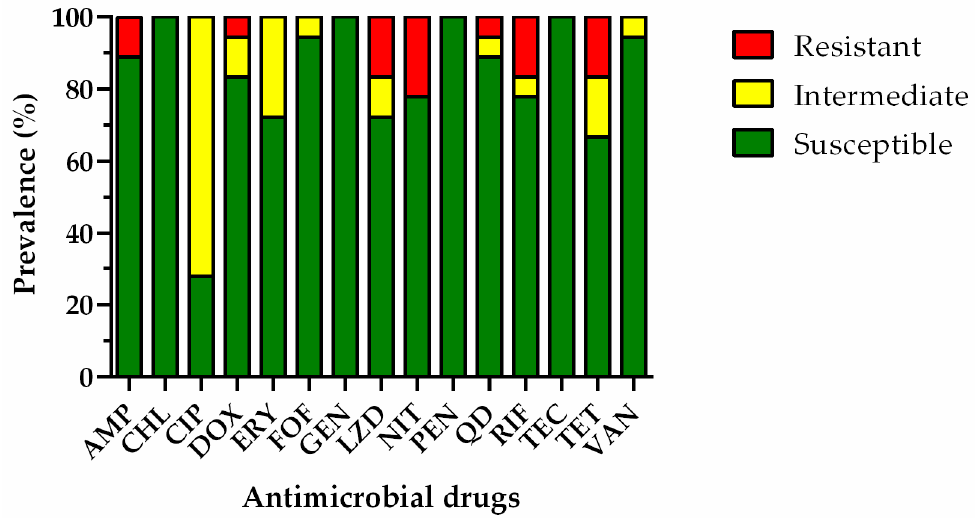
Figure 4. Percentage of resistance in Enterococcus spp. isolated from the farming water and the edible